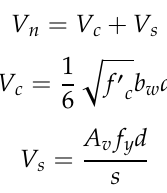
Figure 10. The stiffness degradation curve for series I and II tests.